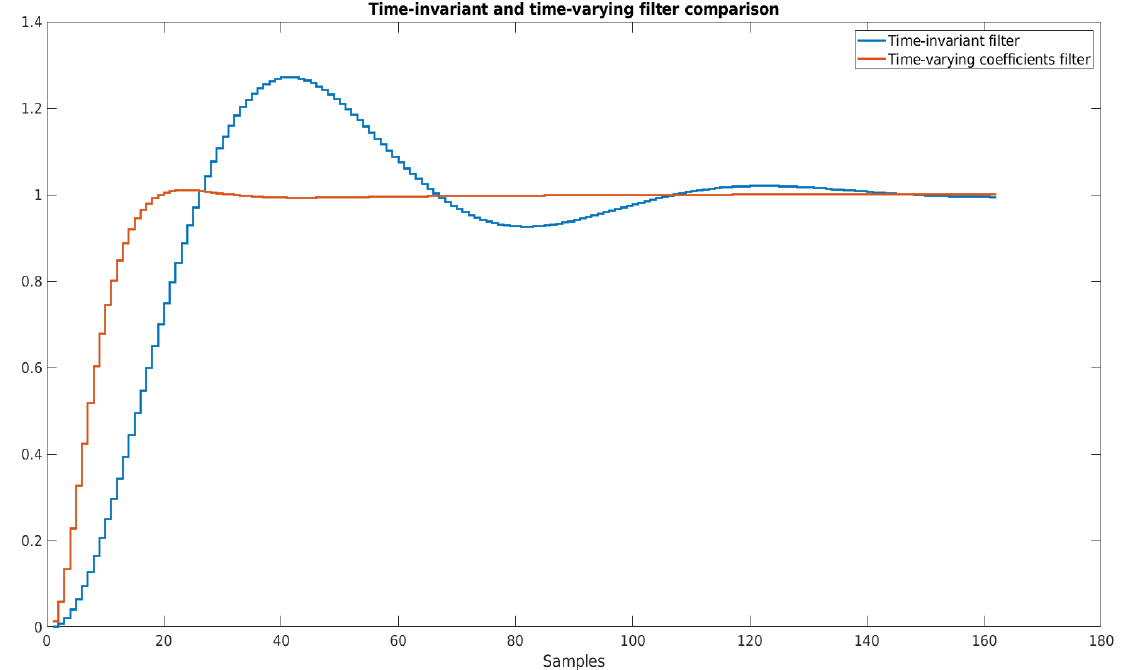
Figure 9. Comparison of the time-invariant and time-varying filtering